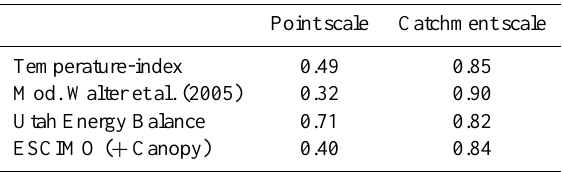
Table 3. Nash–Sutcliffe model efficiencies E derived through cali- bration at the point and the catchment scale, respectively. Statistics refer to the winter season 2005–2006 (calibration period).